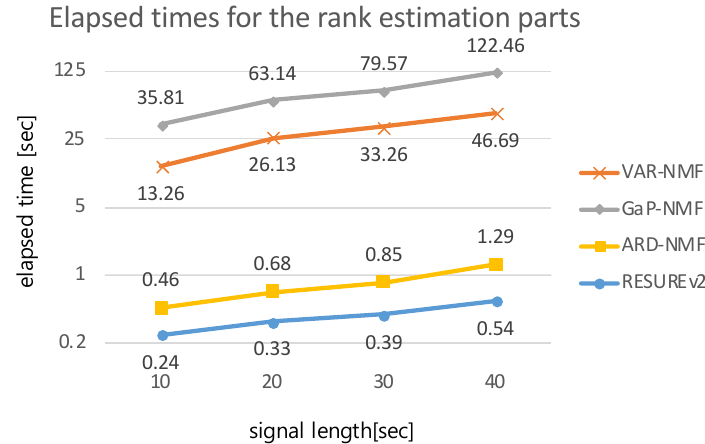
Figure 14. Chart comparing the elapsed times of the parts of various algorithms related to model order selection. The elapsed times were measured using MATLAB on a laptop with a 3.5-GHz dual-core CPU and 16-GB